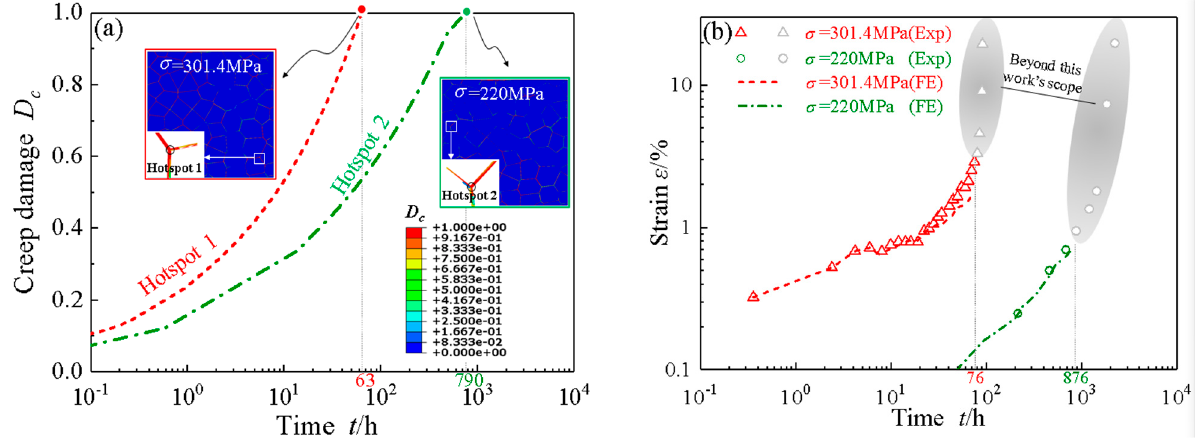
Figure 2. ( a ) Evolution curves of creep damage vs. time of hotspot 1 and 2 and the corresponding contour plots of creep damage; ( b ) Comparison of creep strain vs. time curves between experimental results [31] and simulations at stress of 301.4 MPa and 220 MPa at 600 °C.